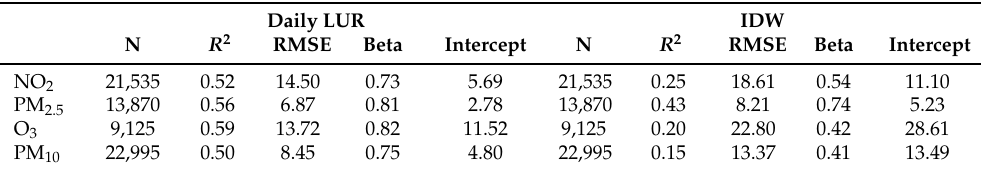
Table 2. Model performance for daily LUR and IDW by regressing daily predictions against daily measurements. N: number of daily mean predictions; R 2 : coefficient of determination; RMSE: root-mean-squared error (unit: µgm − 3 ). Daily